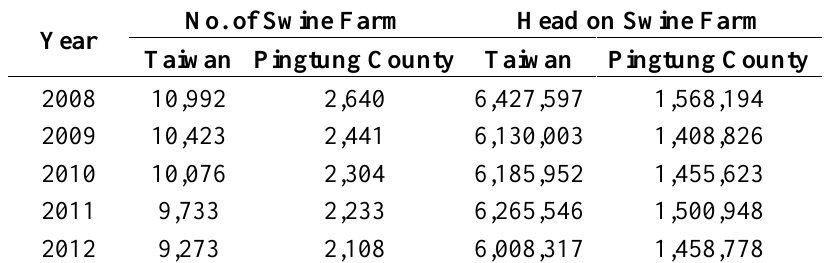
Table 2. Statistics on swine raised in Taiwan and Pingtung county during the years of 2008–2012 [12].